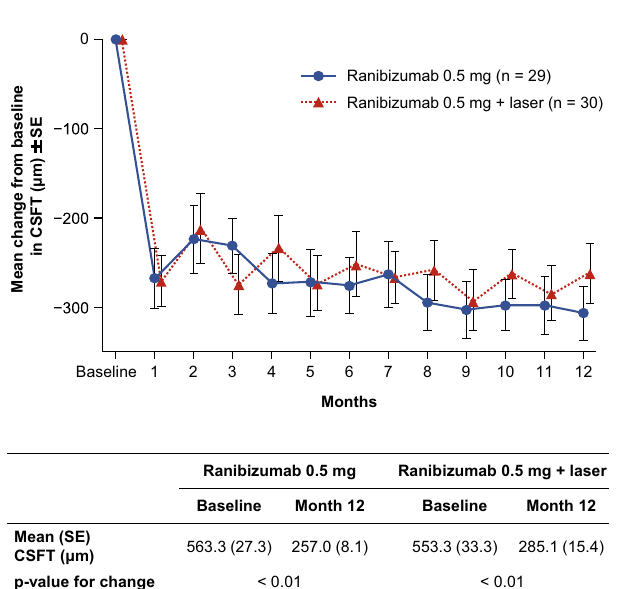
Figure 4. Mean change from baseline in CSFT (µm) ± SE (full analysis set, LOCF). CSFT central subfield thickness, LOCF last observation carried forward, SE standard